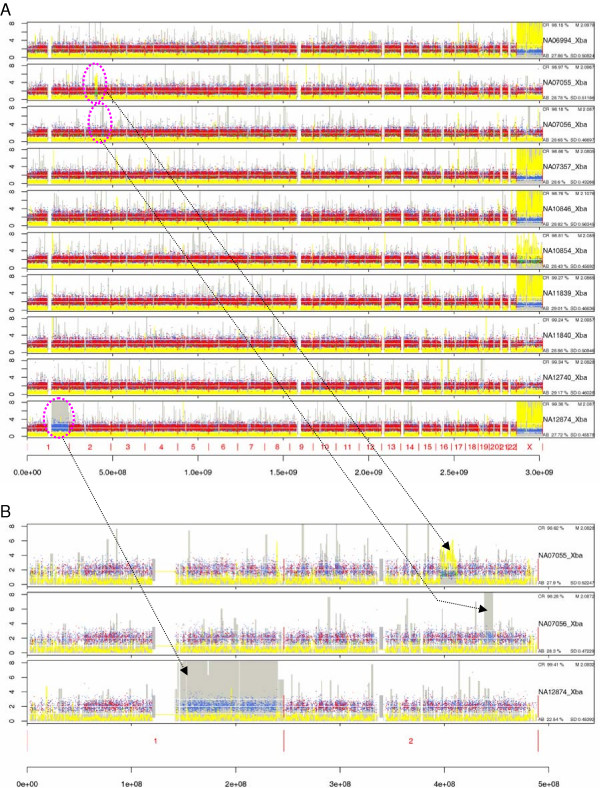
Use of SNPscanPlot to visualize chromosomal anomalies in apparently normal individuals. A. SNP array data for ten individuals, including some chromosomal abnormalities detected using SNPscan. These include: mosaic microdeletion on chr2q for NA07055 (second track from the top, dashed oval); UPD on chr2q of NA07056 (third track, dashed oval); mosaic chromosome X of female NA10854 (sixth track); UPD on chr19p on NA12740 (ninth track); and UPD on chr1q of NA12874 (tenth track, dashed oval). B. Enlarged view of chromosomes 1 and 2 for three individuals show in A; arrows indicate the affected regions.